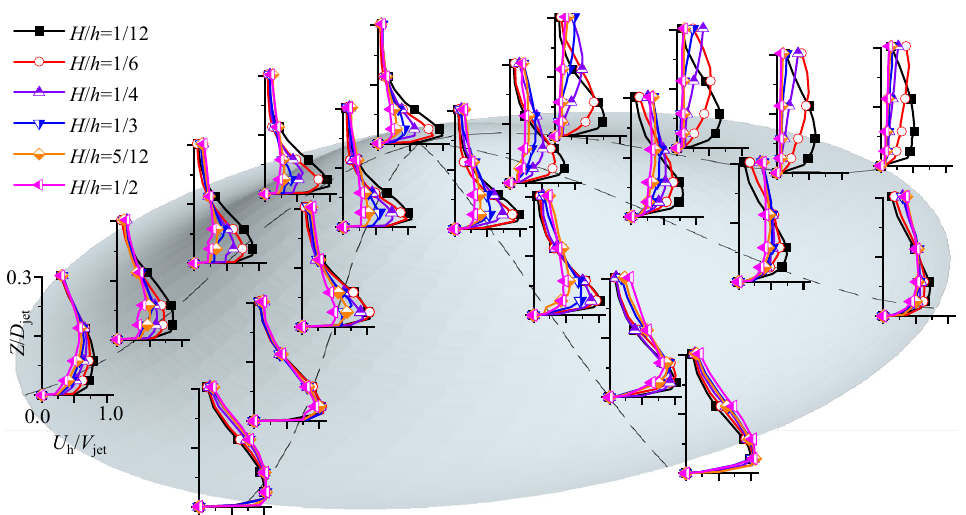
Figure 12. Profiles of horizontal wind velocity ( L = 0.5 D jet , r h = 0.8 D jet ).